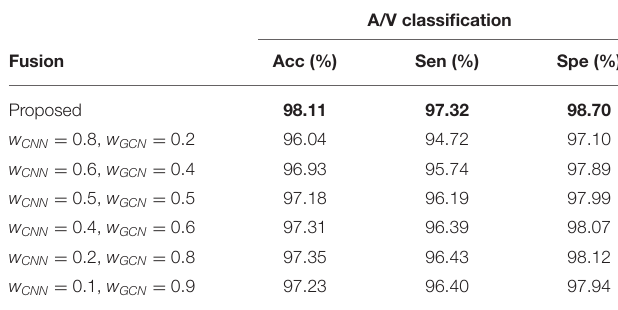
TABLE 6 | Comparison of different fusion options using the AV-DRIVE